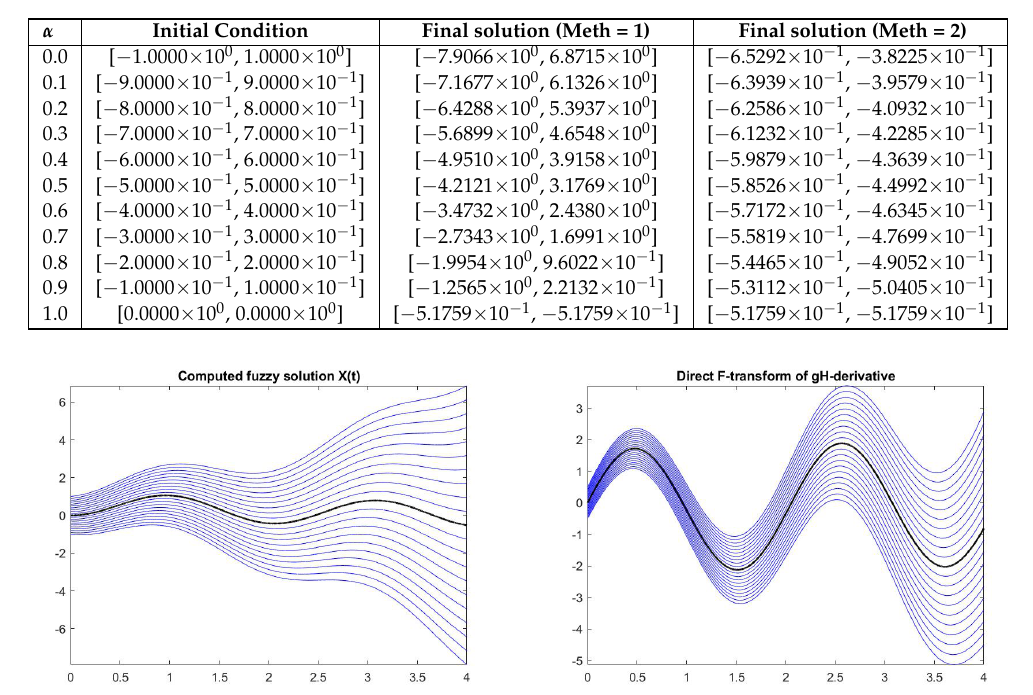
Table 5. (Fuzzy-valued problem FDE1): For eleven values of α ∈ the interval level-wise initial condition (column 2), the final interval value with Meth = 1 (column 3) and the final interval value with Meth = 2.